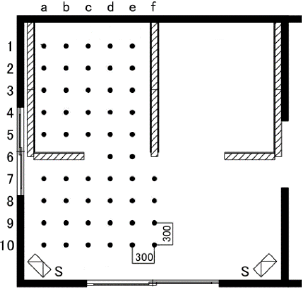
Figure 15. One evaluation space is used for sound-pressure-level measurement. The levels were obtained at dot positions on each absorption pattern (A–E shown in Figure 4).